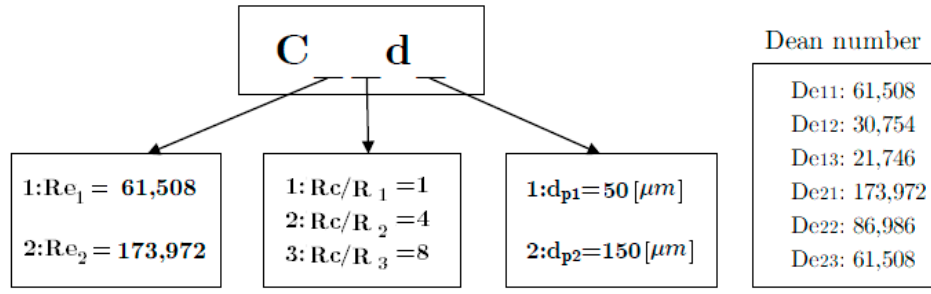
Figure 7. Coding of study case.